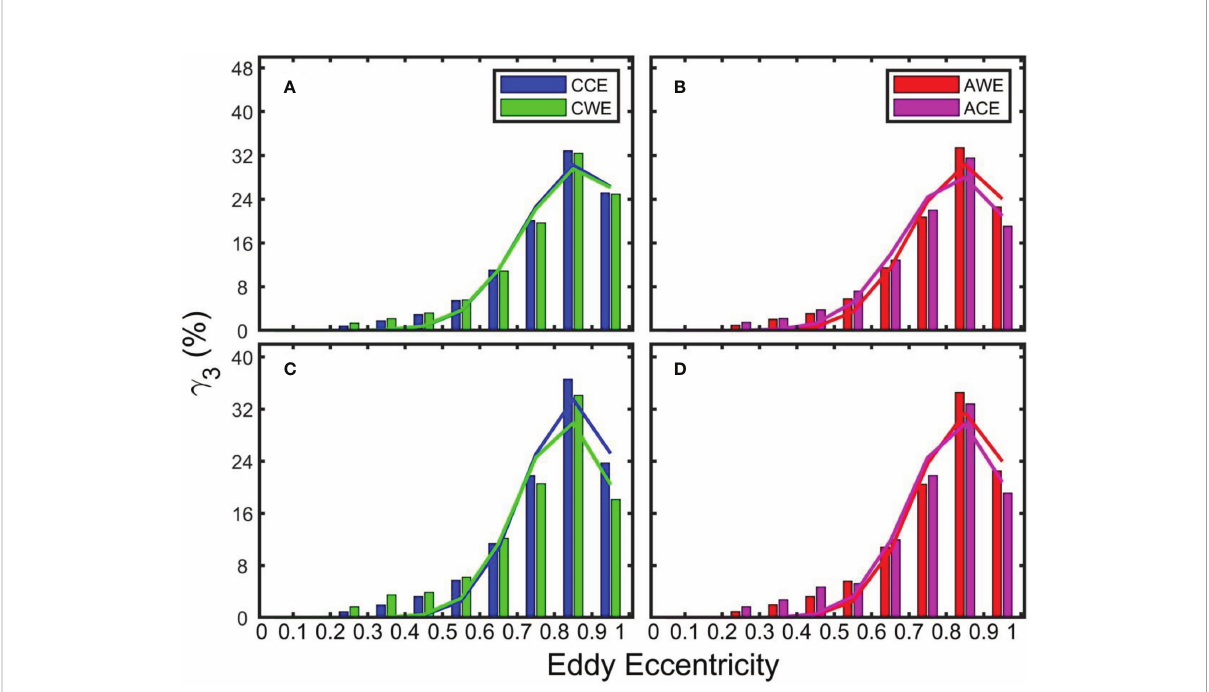
FIGURE 8 Statistical histogram of eddy eccentricity at the sea surface (A, B) and 1,000 m (C, D) . Blue, red, green, and magenta bars represent cyclonic cold-core eddy, anticyclonic warm-core eddy, cyclonic warm-core eddy, and anticyclonic cold-core eddy, respectively. The curves show the distribution of the Gaussian fi tting